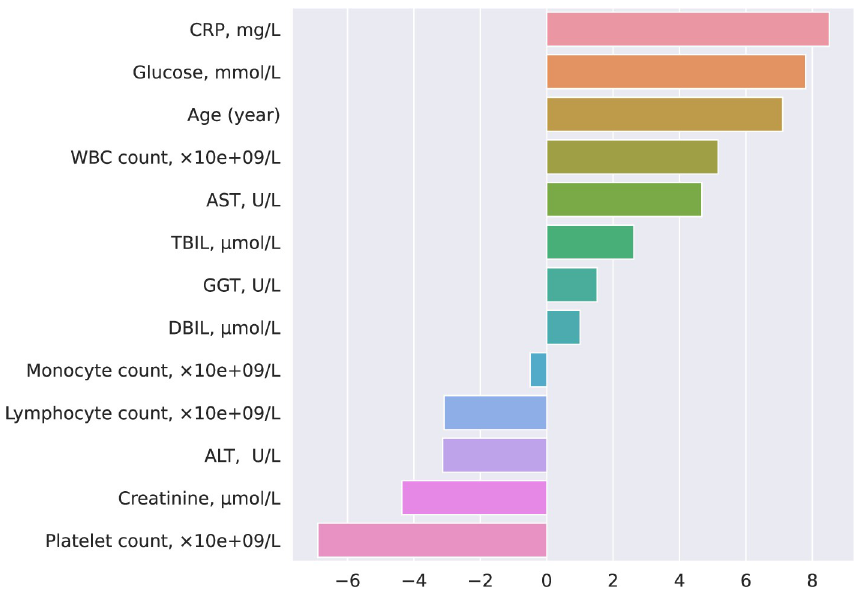
Fig 5. LR coefficients obtained from the biochemistry data. LR model provides direct access to the computed coefficients and summarizes information about the contribution of each feature in the final output. The positive or negative coefficient values indicate an increased or decreased weight passed to the logistic function, which results in obtaining a positive or negative answer, respectively. In our analysis of the disease progression, severe cases were labeled as positive. This allows the identification of the biochemical features related to case severity. To generate compatible coefficient values for parameters with different ranges (e.g. lymphocyte count typically ranges from 0 to 3 while CRP ranges from 0 to 200) we normalized the data using the l2 normalization.